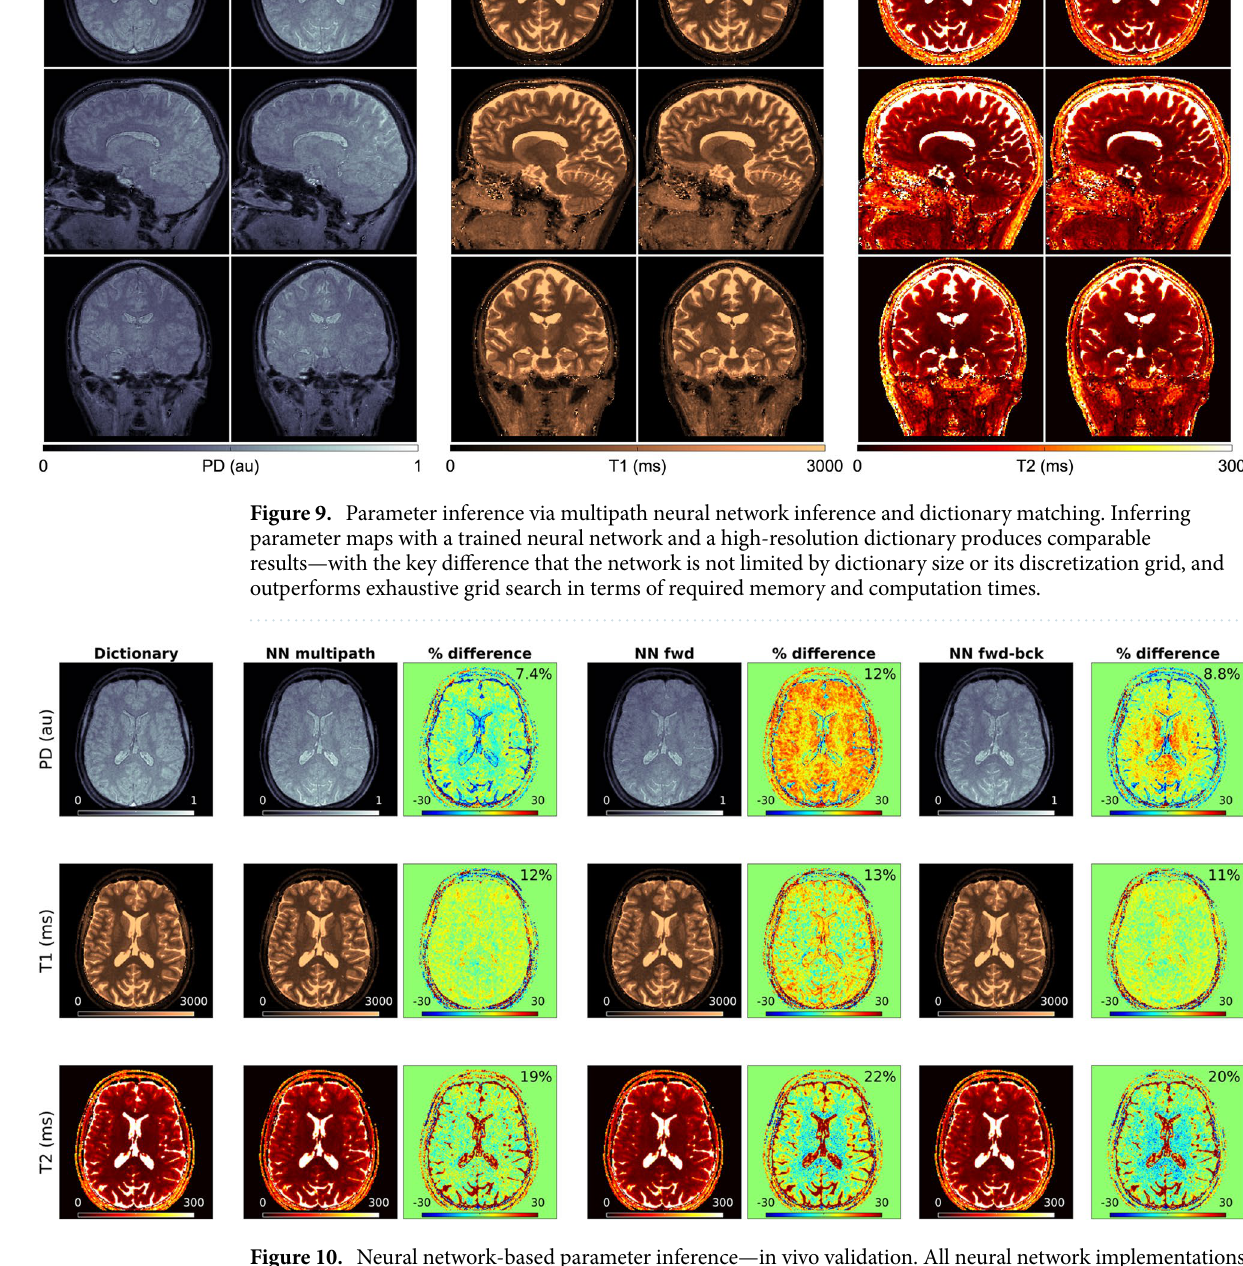
Figure 10. Neural network-based parameter inference—in vivo validation. All neural network implementations provide parametric estimates that are largely consistent with dictionary matching results. For all parameters, the neural network architectures with separate pathways, i.e. NN multipath and NN fwd‑bck , resulted in closer estimates with respect to the dictionary than NN fwd , which is based on a single-pathway